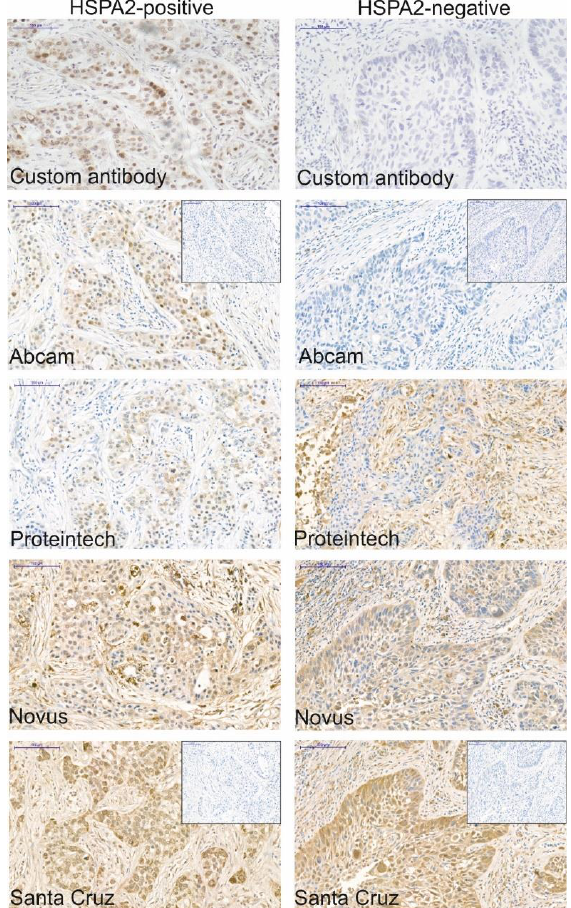
Figure 4. Results of immunohistochemical staining with the use of specific and validated custom anti-HSPA2 antibody [12] and commercial anti-HSPA2 antibodies in NSCLC tumor samples were incubated with primary antibody overnight at 4 °C. Two pairs of HSPA2-positive and -negative samples were analyzed; representative images are shown. The summary on antibody cross-reactivity and on technical details are collected in Tables 2 and 3, respectively. The scale bar represents 100 µm.